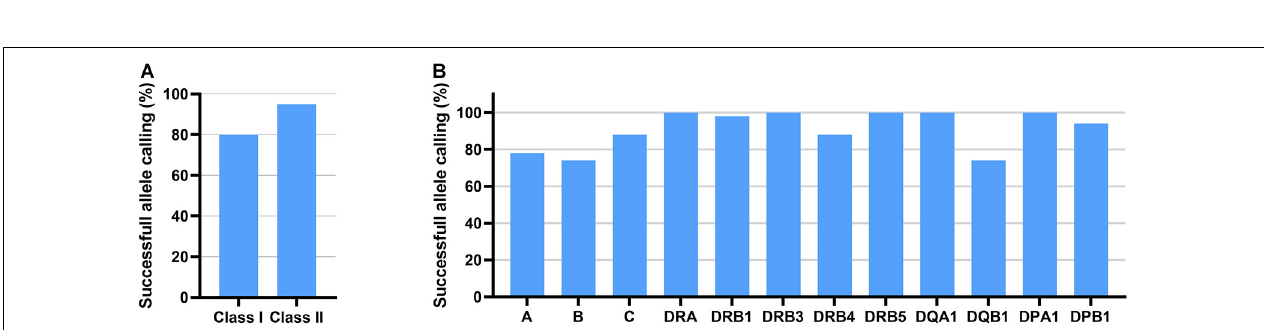
FIGURE 3 | HLA typing results of 50 individuals using ONT RNAseq data and SeqPilot software. Successful allele calling rate is shown for class I and class II (A) and for each gene (B) .